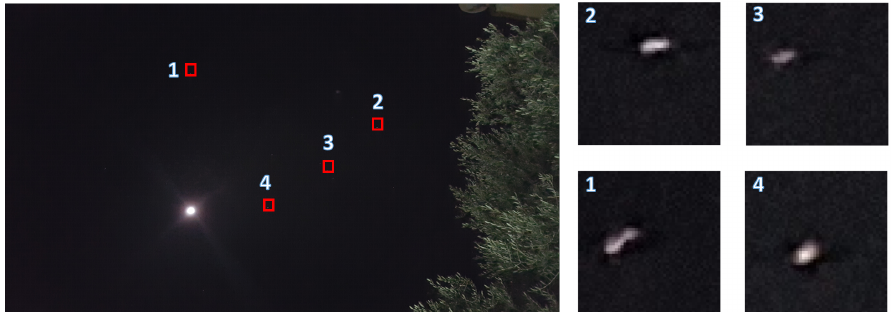
Figure 17. Star Pixels excepted inaccuracy. The four rectangles on the left are enlarged parts of the frame on the left. Each of the rectangles size is 50 × 50 pixels and in it are examples for star appearance on the